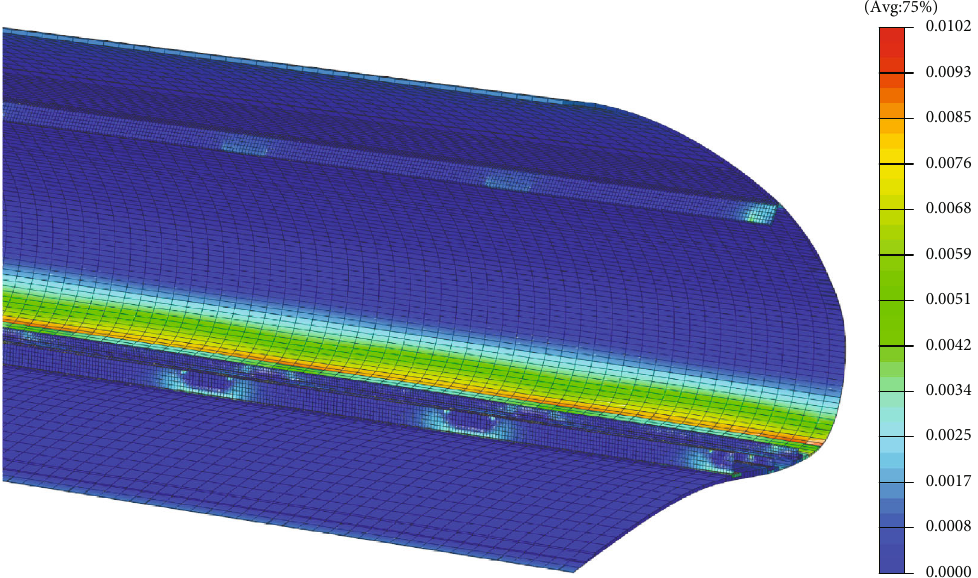
Figure 8: Maximum principal strain distribution in the